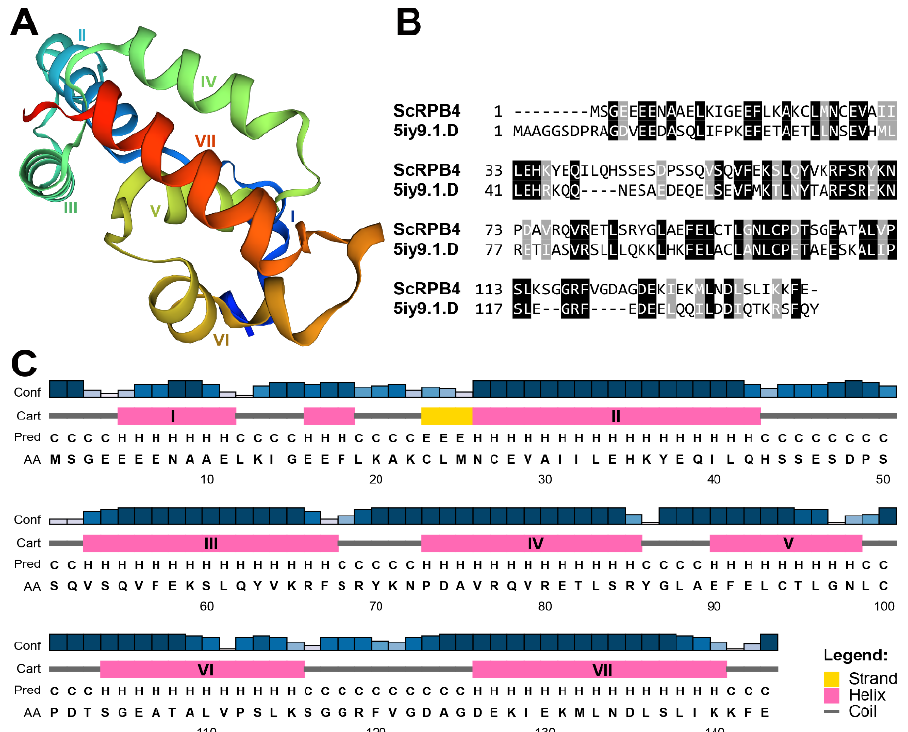
Figure 1. Structural analysis of the sugarcane Rpb4 protein. ( A ) The predicted tertiary structure of the ScRpb4 using the human Rpb4 protein (PDB ID: 5iy9.1.D) as a template. Different helical structures are indicated as I-VII. ( B ) Pairwise sequence alignment between ScRPB4 and human RPB4 (5iy9.1.D). ( C ) Secondary structural prediction of ScRPB4 protein. Conf, confidence of prediction; Cart, 3-state assignment cartoon (Strand, Helix, or Coil); Pred, 3-state prediction (E, strand; H, helix; C, coil); AA, amino acid sequences. Helices assigned as I-VII correspond to those from figure A. of the 3D structure.